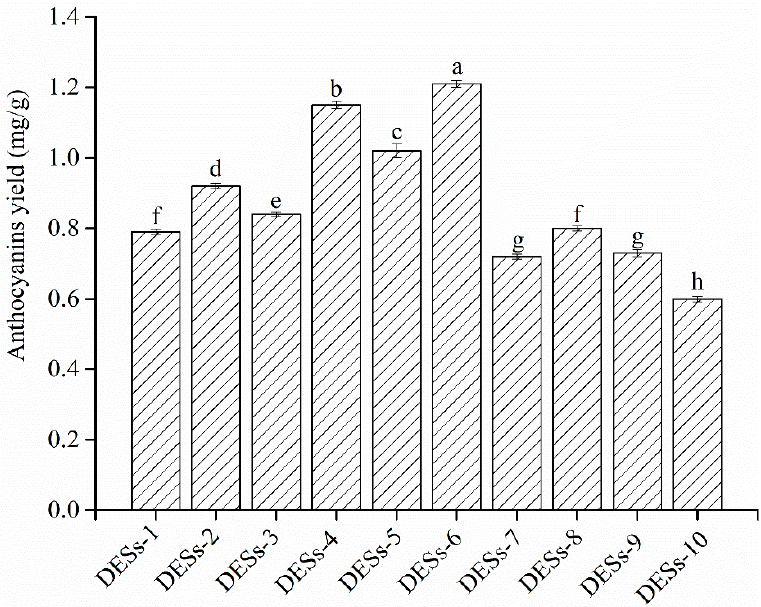
Figure 1. E ff ect of di ff erent deep eutectic solvents (DESs) on the yield of anthocyanins from raspberries. Figure 1. Effect of different deep eutectic solvents (DESs) on the yield of anthocyanins from The di ff erent lower-case letters indicate significant di ff erences ( p < raspberries. The different lower-case letters indicate significant differences ( p < 0.05).